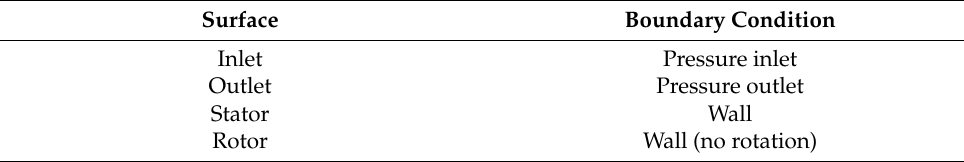
Figure 2. Geometrical parameters of a straight‐through labyrinth seal. Table 1. Boundary conditions of the computational fluid dynamic (CFD) Table 1. Boundary conditions of the computational fluid dynamic (CFD) domain.